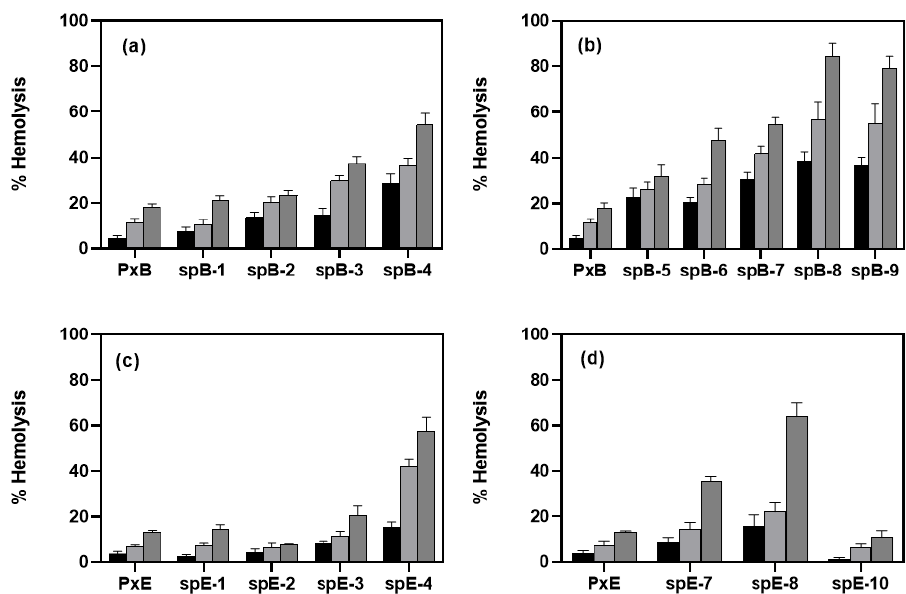
Figure 2. Hemolysis induced by the synthetic analogues of ( a ) Series I-PxB; ( b ) Series II-PxB; ( c ) Series I-PxE; ( d ) Series II-PxE (sequences in Table 1). Erythrocytes were incubated for 1 h at 37 °C with 8 µM (black), 45 µM (light gray), or 335 µM (dark gray) of each lipopeptide. Data correspond to the average of three independent experiments (error bars = SD).